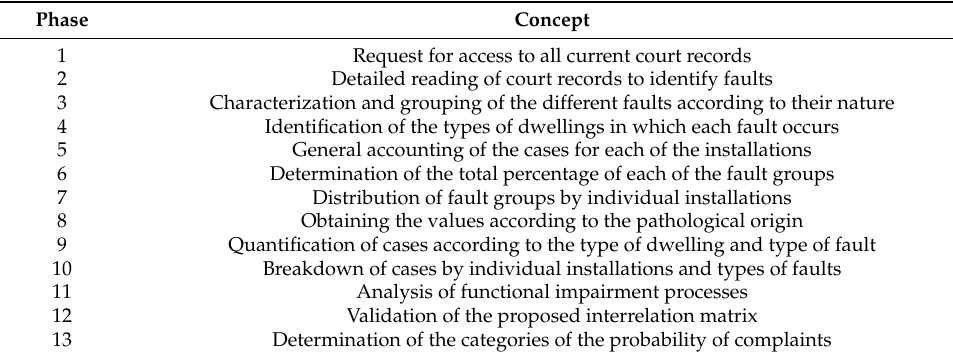
Table 1. Phases in the data collection and reading